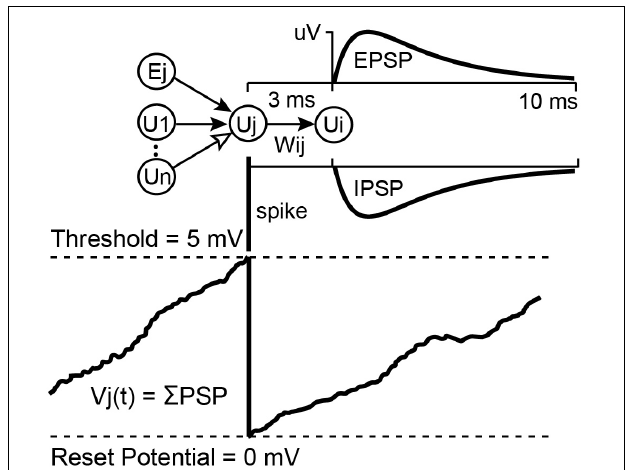
FIGURE 5 | Unit potential calculation for the integrate-and-fire neural network. Spiking input from connected units sum into a target unit’s potential Vj(t). If Vj(t) reaches threshold it is reset to 0 and the unit sends a spike to all of its target units, which will cause a Post Synaptic Potential proportional to Wij. These PSPs may be excitatory or inhibitory, depending on the sign of Wij (for more details see Shupe and Fetz,